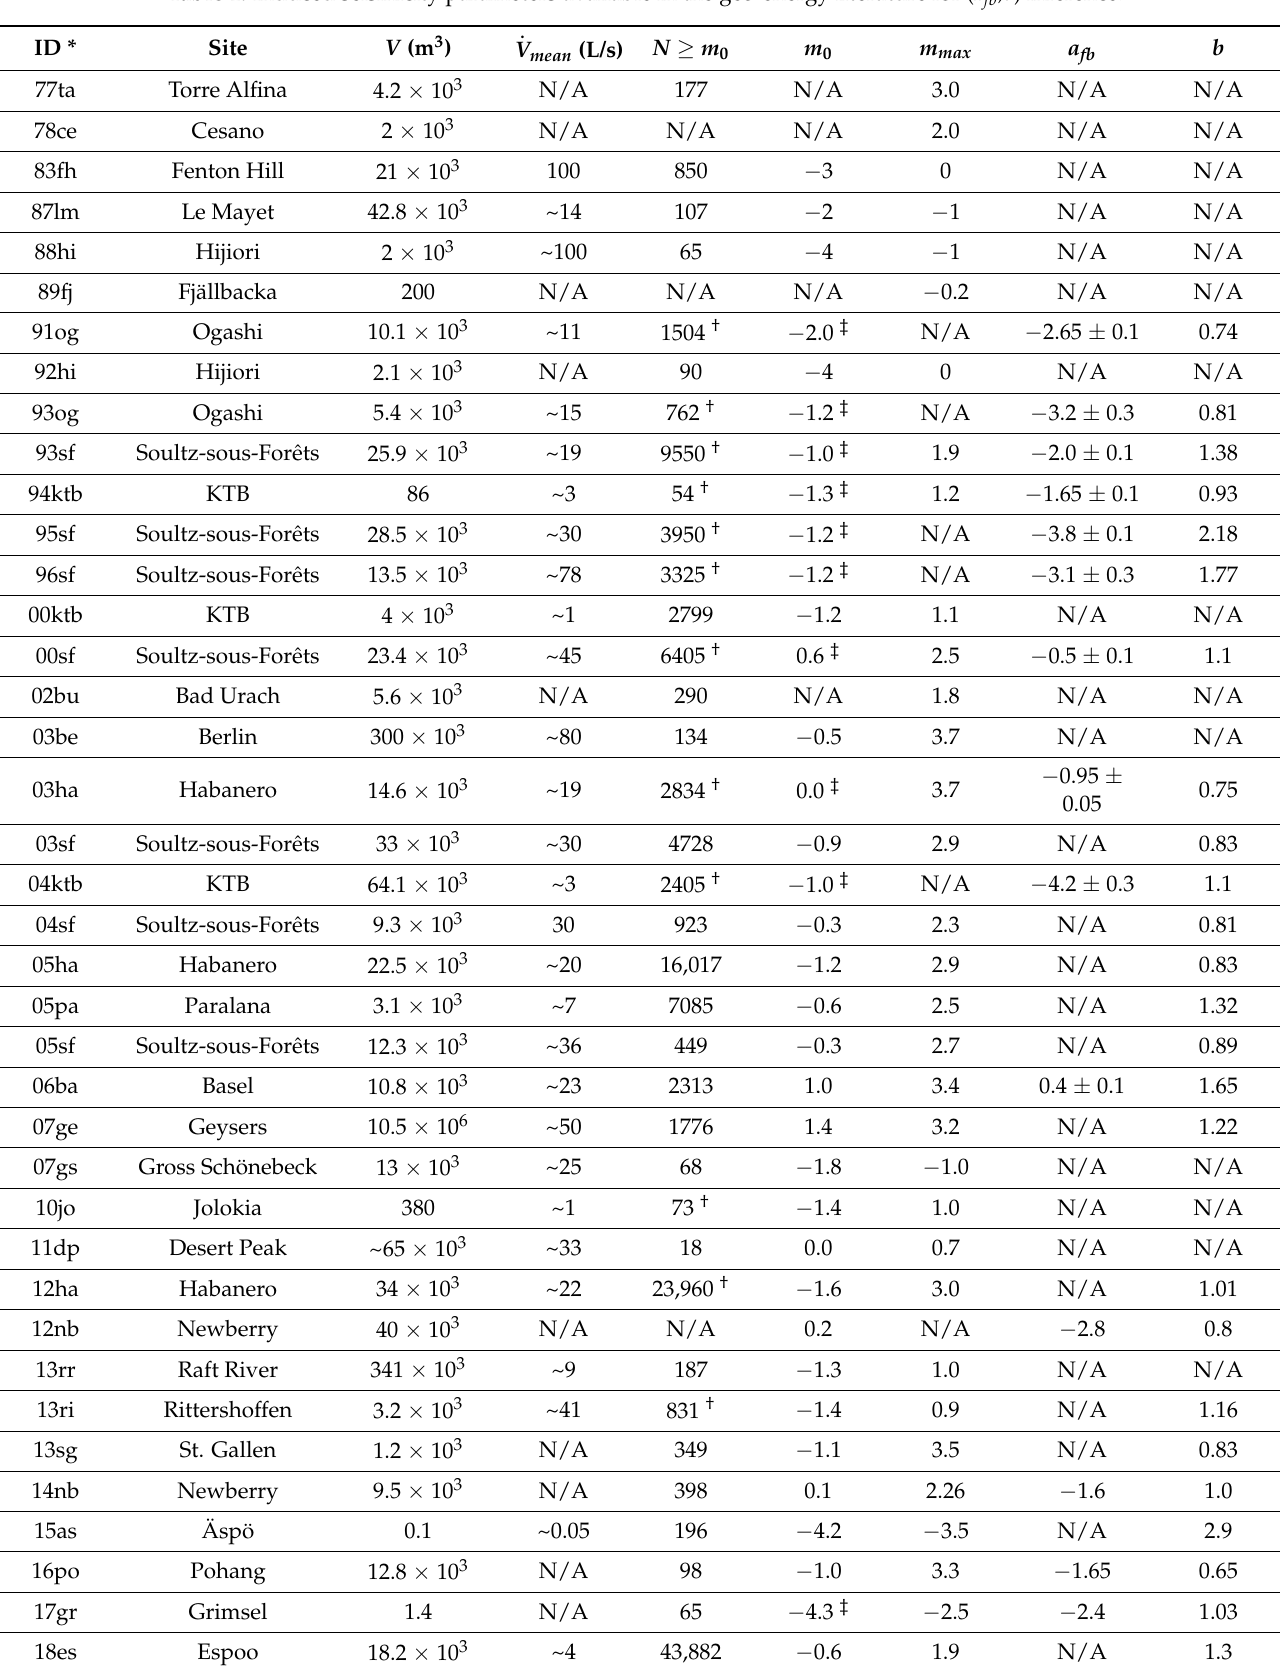
Table 1. Induced seismicity parameters available in the geo-energy literature for ( a fb ,b )